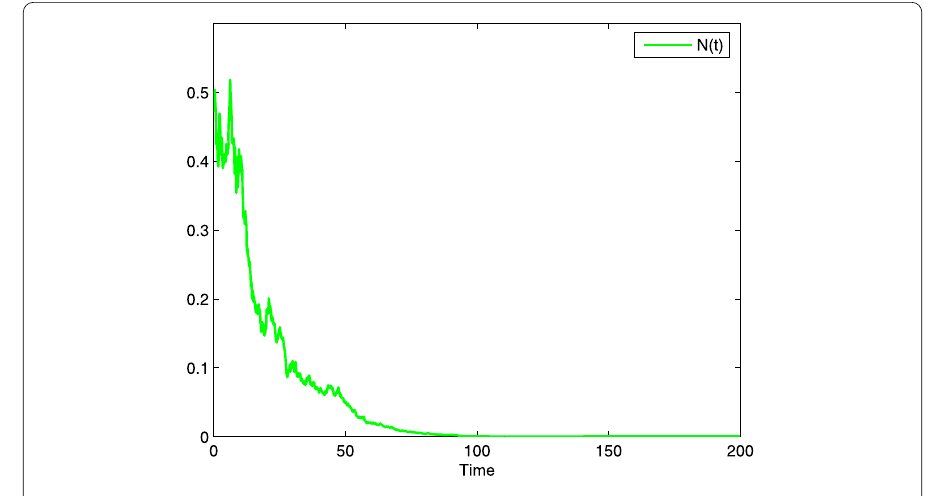
Figure 1 A trajectory of subsystem (15) with r (1) = 0.2, ρ (1) = 0.1, (cid:5) 2 (1) = 0.8, a = 1, θ (1) = 0.1, β (1) = 0.05, b = 2. This figure suggests that the species represented by subsystem (15) vanishes